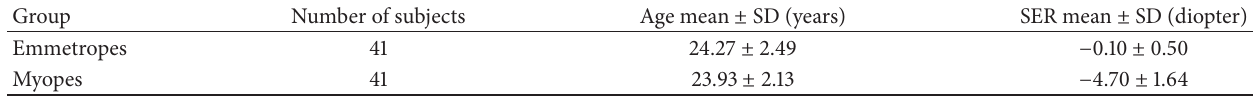
Table 2: Distribution of the subjects according to age and spherical equivalent refraction (SER).